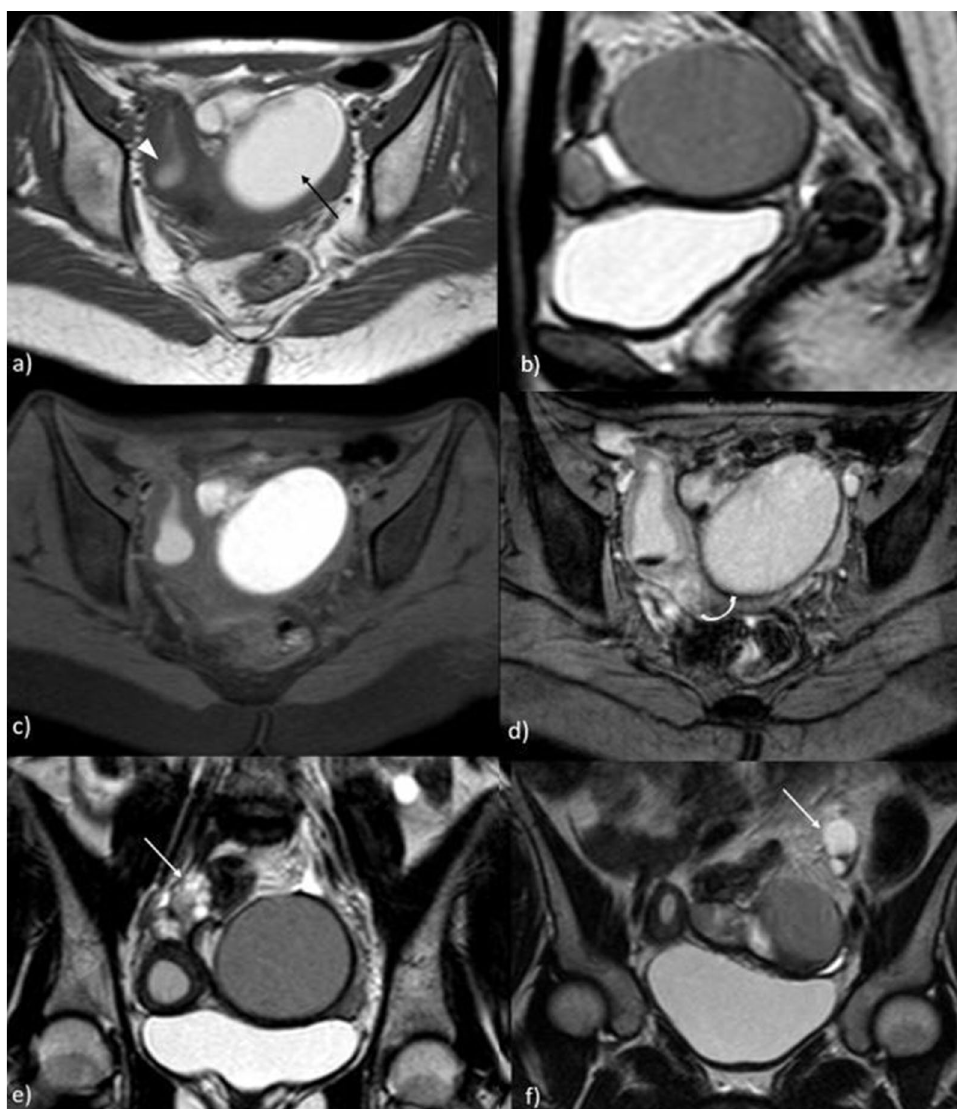
Fig. 3 MRI pelvis of a 14-year-old female with primary amenorrhea and cyclic lower abdominal pain. Axial T1W SE image ( a ) reveals a small rudimentary uterus in right hemipelvis, with hyperintense contents (white arrowhead) within the endometrial cavity and a large dilated right fallopian tube with hyperintense contents (black arrow). Mid-sagittal T2W SE sequence ( b ) depicts shading within the rudimentary horn and tube, with non-visualization of cervix and vagina. Axial T1 FS ( c ) shows no suppression of T1 hyperintense contents, confirming hematometra and hematosalpinx. Axial T2*GRE ( d ) shows hemosiderin lining of the hematosalpinx (curved arrow) and dependent blooming foci in the rudimentary horn. Cervix and vagina were not visualized on MRI, suggesting their aplasia. Right ovary ( e ) and left ovary ( f ) (white arrows) are normal. Features are consistent with Mayer-Rokitansky-Küster-Hauser syndrome with functional rudimentary right horn with hematometra, right hematosalpinx, and aplastic cervix and